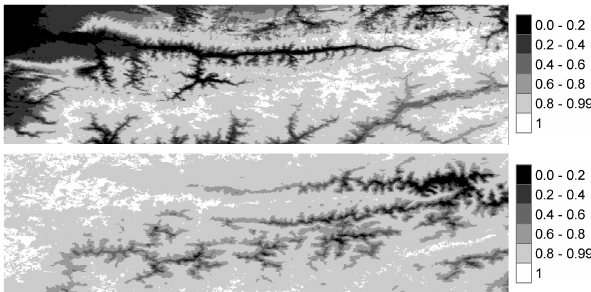
Figure 4. CP maps for snow (top) and land (bottom) conditions of Chimgan station (see Fig. 1) for the study area. The figure shows the same domain as Fig.